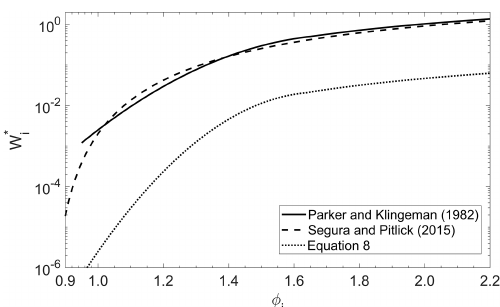
Figure 5. Comparison between different subsurface-based sedi- ment transport equations and the one proposed in this study. The relation of Segura and Pitlick (2015), which is also a modified ver- sion of Parker and Klingeman (1982), is shown as